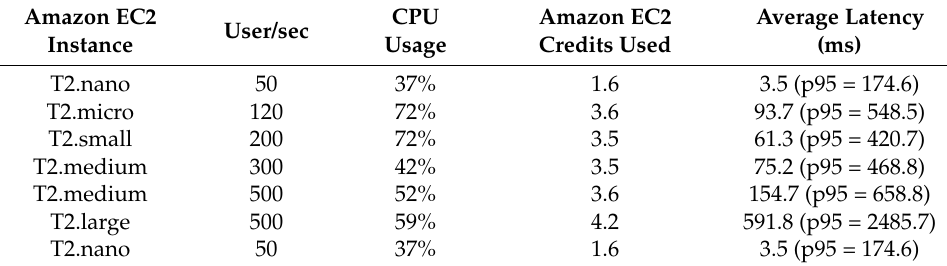
Table 7. Summary of the performance test results.